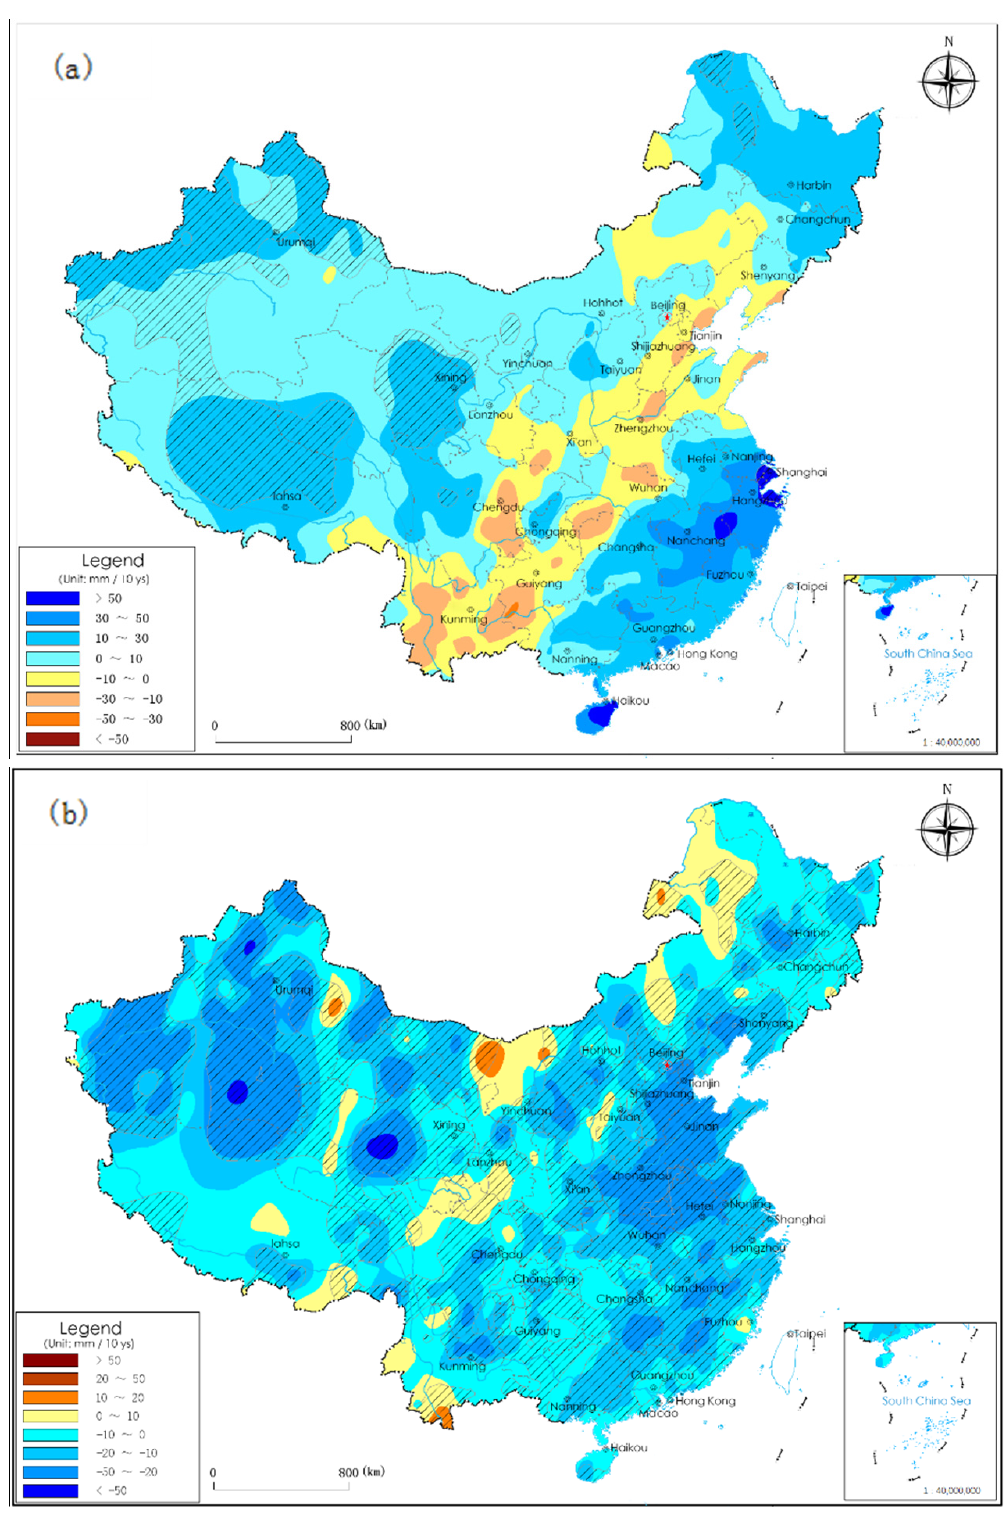
Figure 3. Linear trends of annual precipitation ( a , color filled areas); and annual PET ( b , color filled areas); the significance test passed the 95% confidence level area ( a and b , slant line areas) in China from 1961 to 2020.